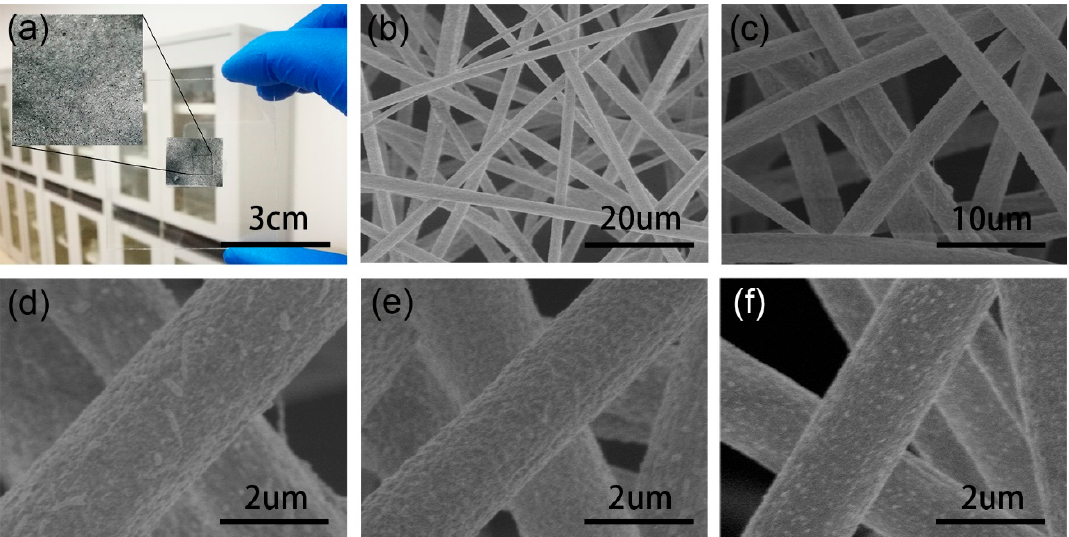
Figure 2. Optical and SEM images of the composite fibers. ( a ) Optical image of the composite fibers. ( b – f ) SEM images of the composite fibers: ( b – d ) M85.7, ( e ) M77.7, and ( f ) M66.6.